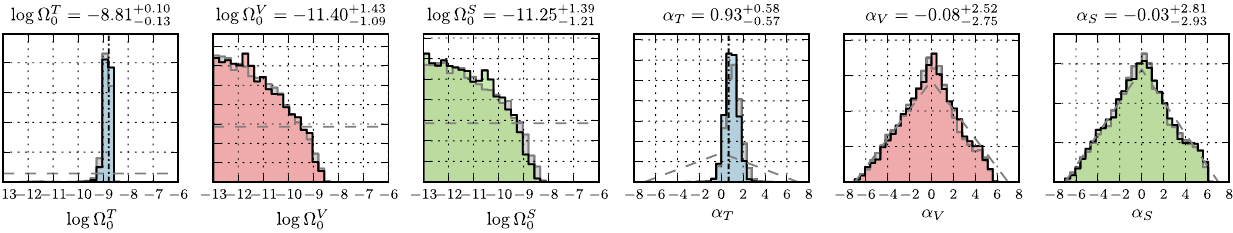
FIG. 13. Marginalized amplitude and slope posteriors for the tensor background observation in Fig. 12, after the additional inclusion of design-sensitivity Advanced Virgo. For reference, the light gray histograms show the Advanced-LIGO-only results from Fig. 12. The joint LIGO-Virgo parameter estimation yields a slightly tighter measurement of Ω T 0 , as well as somewhat improved upper limits on Ω V 0 and Ω S 0